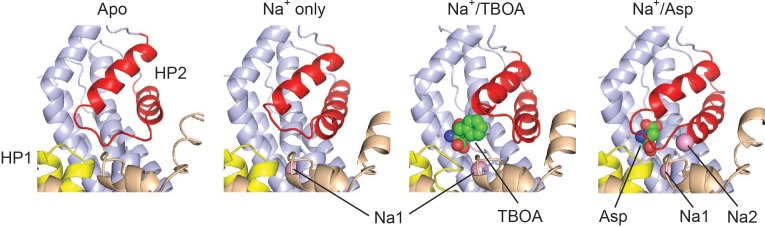
HP2 acts as a gate for substrate binding.Shown are structures of the outward-facing GltPh free of ligands (Apo), R397A mutant crystallized in high Na+ concentration and no substrate (Na+ only), GltPh bound to Na+ ions and L-TBOA (Na+/TBOA) or L-asp (Na+/Asp). The color scheme is as in Figure 1—figure supplement 1. PDB codes are 4OYE, 4OYF, 2NWW and 2NWX, respectively.